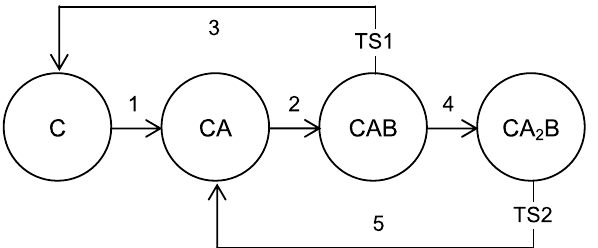
Figure 1. Graph representation of the suggested model; C denotes cluster, A and B denote reagent particles; TS denotes transition state.